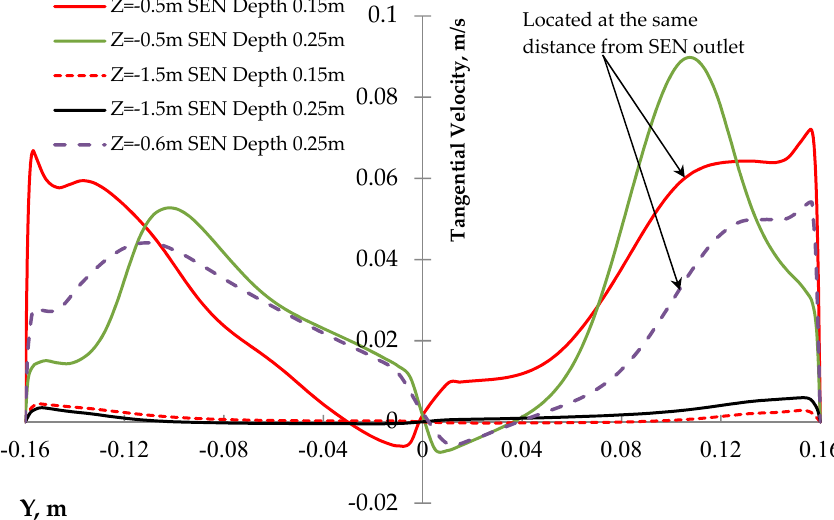
-0.02 Figure 6. Tangential velocity distribution along different horizontal lines in different mold depths. Figure 7 shows the velocity magnitude distribution along different lines in mold depth direction. Figure 7a is the velocity distribution at Location A with 1 cm away from the solidification shell.